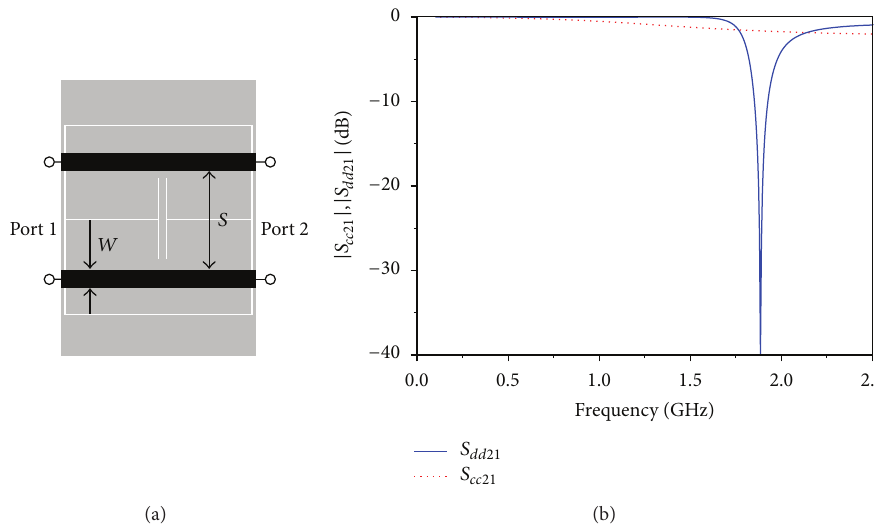
Figure5:DifferentialmicrostriplineloadedwithanMLCwiththeelectricwallalignedwiththeline(a)andfrequencyresponse(transmission coefficient) for the common ( 𝑆 𝑐𝑐21 ) and differential ( 𝑆 𝑑𝑑21 ) modes (b). The substrate is Rogers RO3010 with thickness ℎ = 1.27 mm and dielectric constant 𝜀 𝑟 = 11.2 . The line dimensions are 𝑊 = 1 mm and 𝑆 = 5 mm, corresponding to a 50 Ω odd-mode impedance without the presence of the MLC. The MLC dimensions are 𝑤 1 = 4 mm, 𝑤 2 = 𝑙 1 = 𝑠 = 0.2 mm, and 𝑙 2 = 𝑙 3 = 10